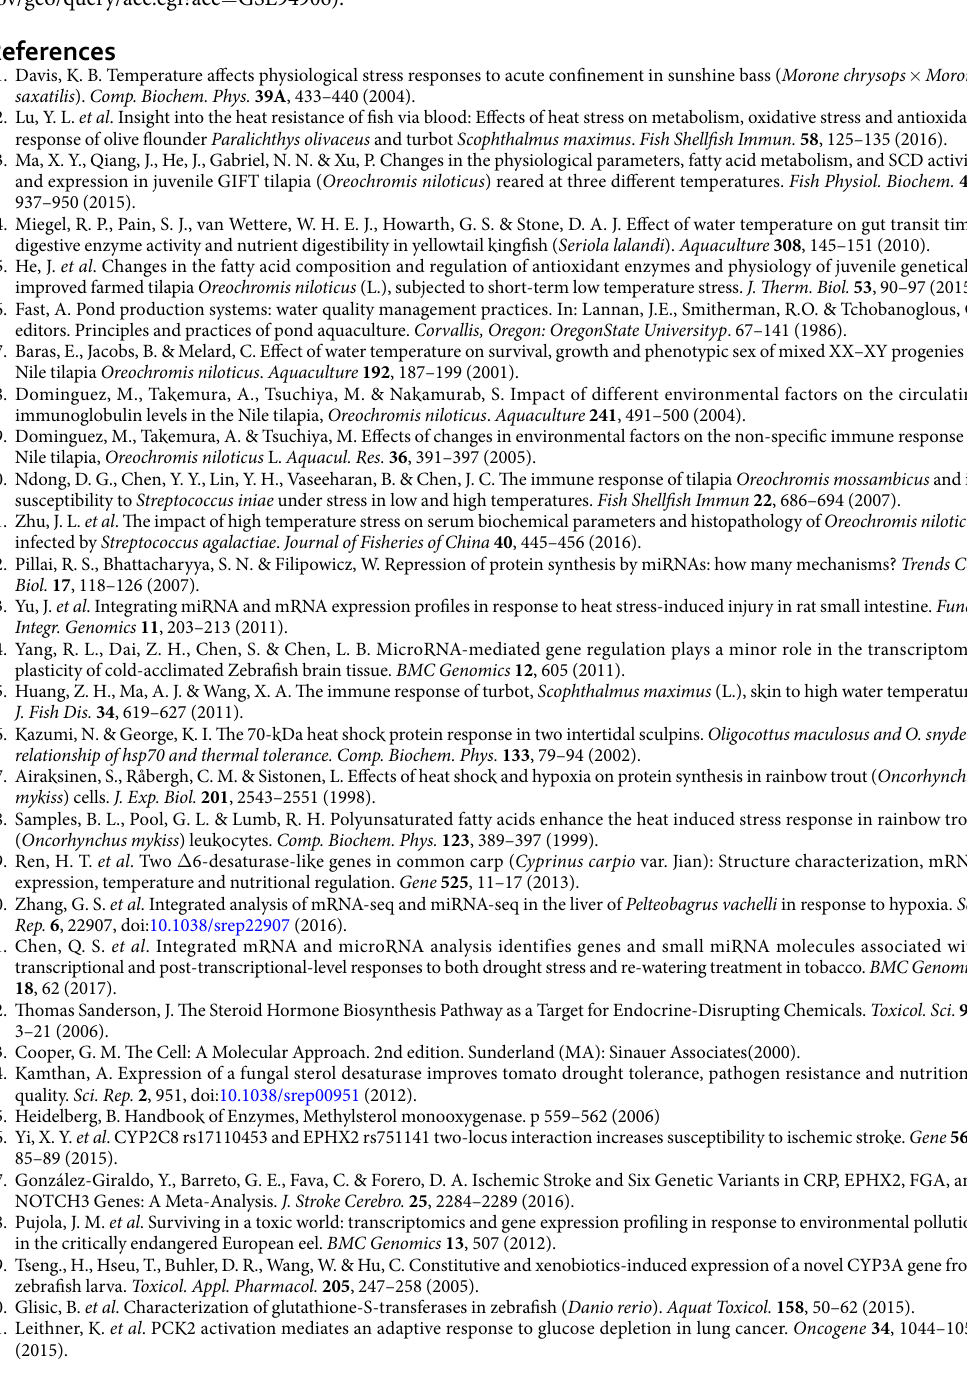
fold changes in expression relative to U6 were calculated by the 2 −ΔΔ Ct method 72 . The miRNA specific primers (Supplementary Table S11) were synthesized by Genewiz, Inc. (Genewiz, Suzhou, China). PrimeScript ™ RT Master Mix and SYBR ® Premix Ex Taq kits (Takara, Dalian, China) were used for the RT reaction and qRT-PCRs of the mRNAs. The RT and PCR reaction methods followed those of our previous study 68 . The 18 S rRNA transcript level was taken as a reference. The primers (Supplementary Table S12) were synthesized by Shanghai GeneCore Bio Technologies Co., Ltd. (Shanghai, China). The mRNA expression levels were presented and analysed using the methods described above for the miRNAs. The mRNA expression levels were quantified using an ABI 7900HT Fast Real-Time PCR System (Applied Biosystems, NY, USA) and com- pared using Relative Quantification (RQ) manager software. We used Student’s T-tests to analyse the qRT-PCR expression